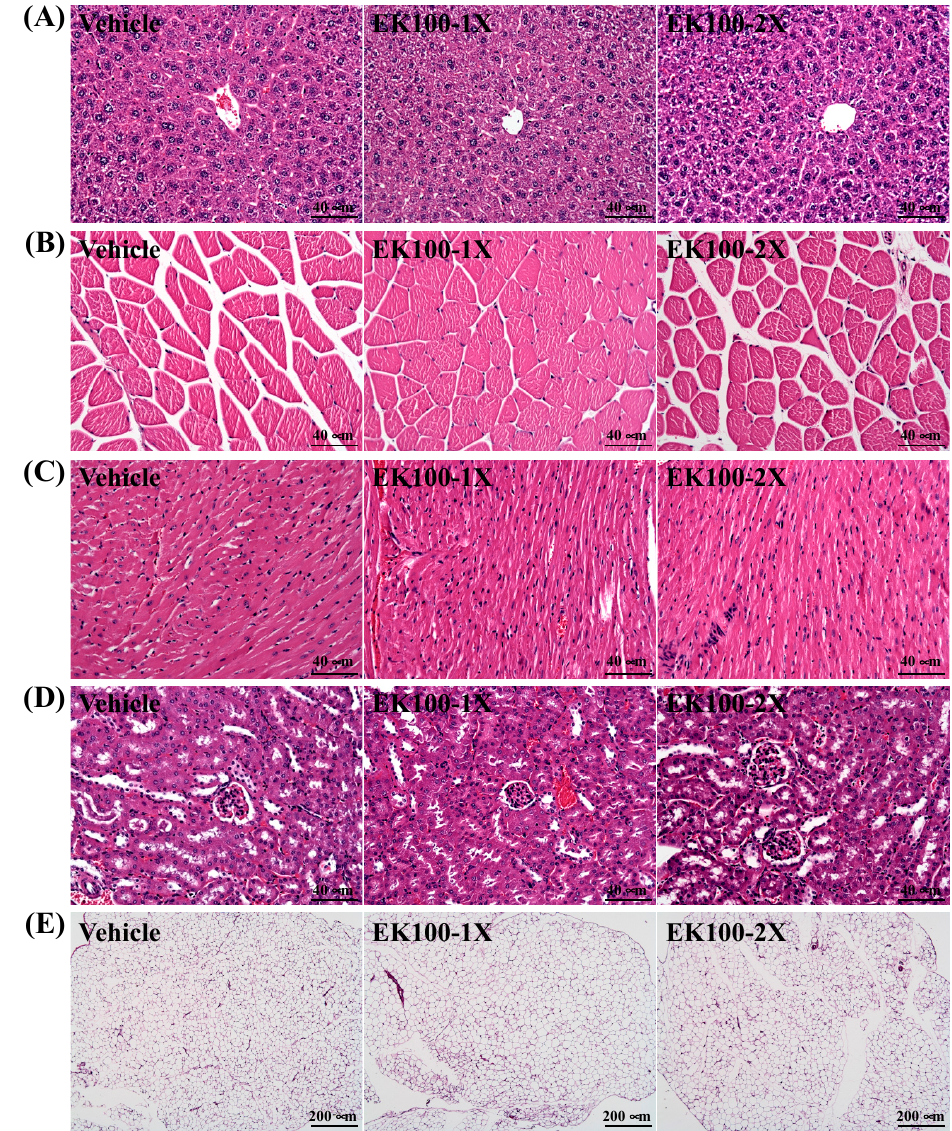
Figure 6. Effect of EK100 supplementation on the morphology of ( A ) liver, ( B ) skeletal muscle, ( C ) heart, ( D ) kidney, and ( E ) epididymal fat pad. Specimens were photographed with a light microscope (Olympus BX51). H&E stain, magnification: ×400, Scale bar, 10 μ m.